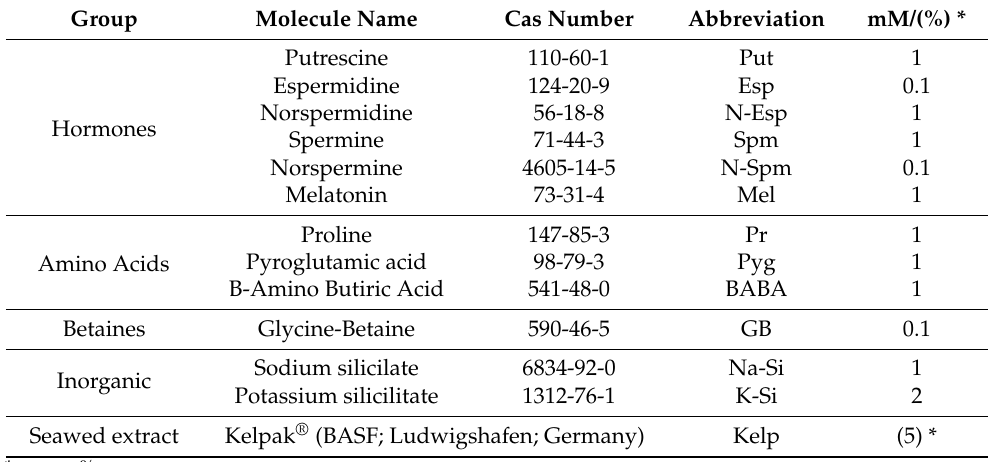
Table 1. Biostimulants used in the experiments and their